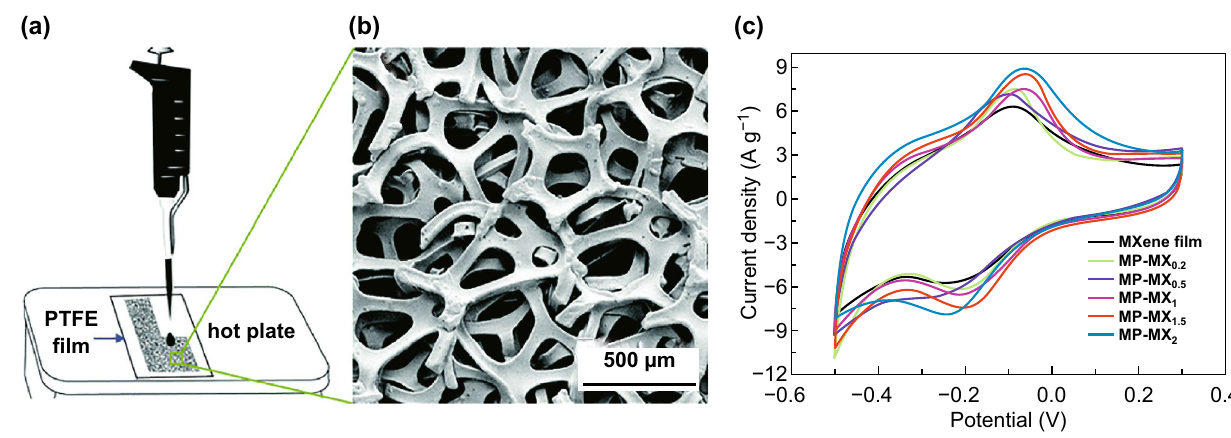
Fig. 5 Ti 3 C 2 T x film. a Schematic of the preparation of the nanoporous Ti 3 C 2 T x films. b SEM image of nickel foam [92]. c CV curves of Ti 3 C 2 T x film and modified nanoporous films at a scan rate of 10 mV s −1 . MP-MX x means the nanoporous Ti 3 C 2 T x film is obtained, where x is the mass ratio of Fe(OH) 3 hybrid [94]. Reproduced with permission from Refs. [92,